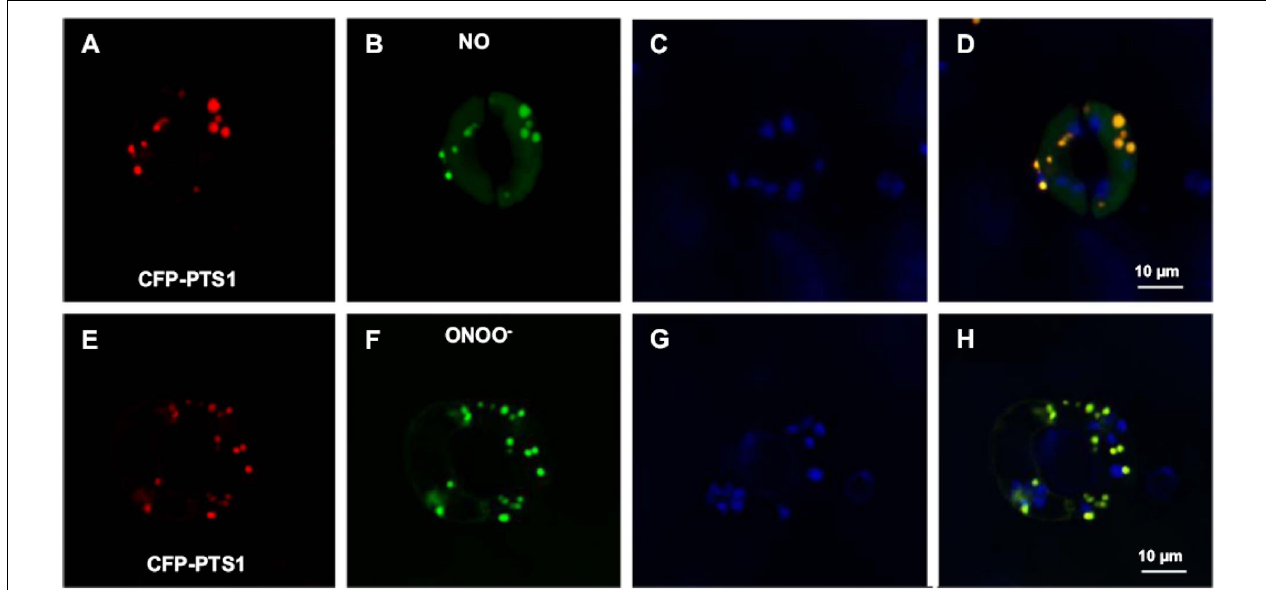
FIGURE 3 | Representative images illustrating the CLSM in vivo detection of nitric oxide (NO) and peroxynitrite (ONOO - ), peroxisomes (red) and chloroplasts (blue) in guard cells of transgenic Arabidopsis seedlings expressing CFP-PTS1. (A,E) Fluorescence punctate (red) attributable to CFP-PTS1, indicating the localization of peroxisomes in guard cells. (B,F) Fluorescence punctate (green) attributable to the detection in the same guard cells of NO and ONOO - , respectively. (C,G) Chlorophyll autofluorescence (blue) attributable to the detection of chloroplasts. (D,H) Merged images for corresponding panels. Reproduced with permission from Corpas et al. (2017a) provided by